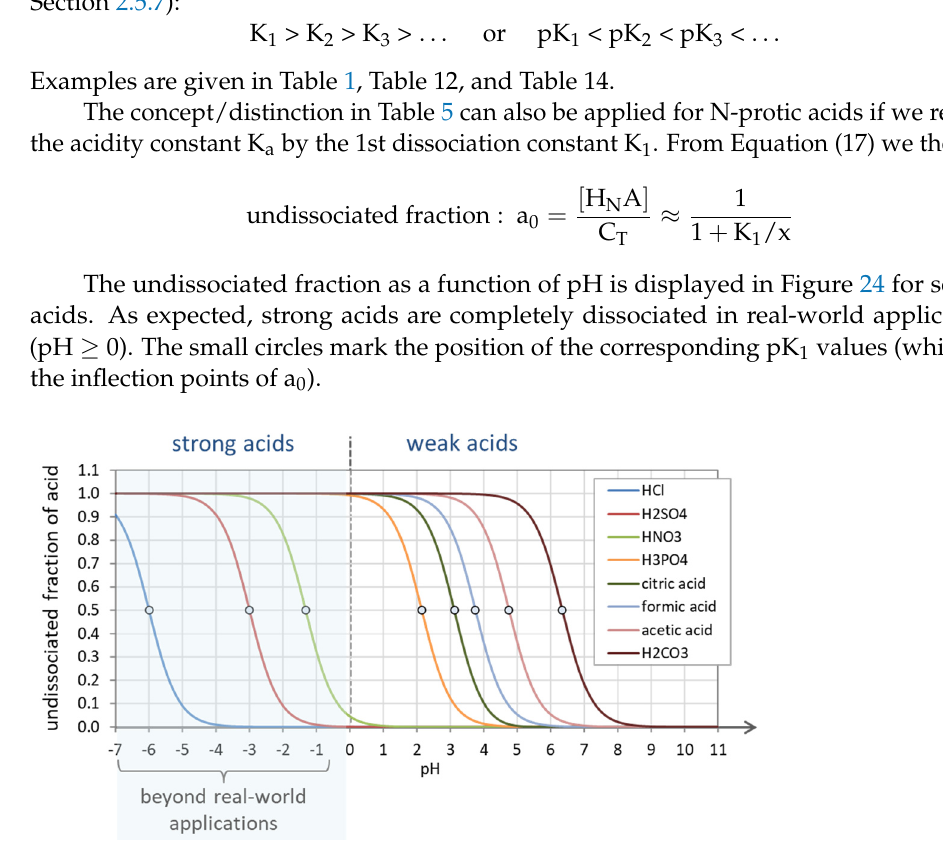
Figure 24. Undissociated fraction a 0 for strong and weak acids. Strong acids are completely dissociated in the pH range above pH ≈ 0.